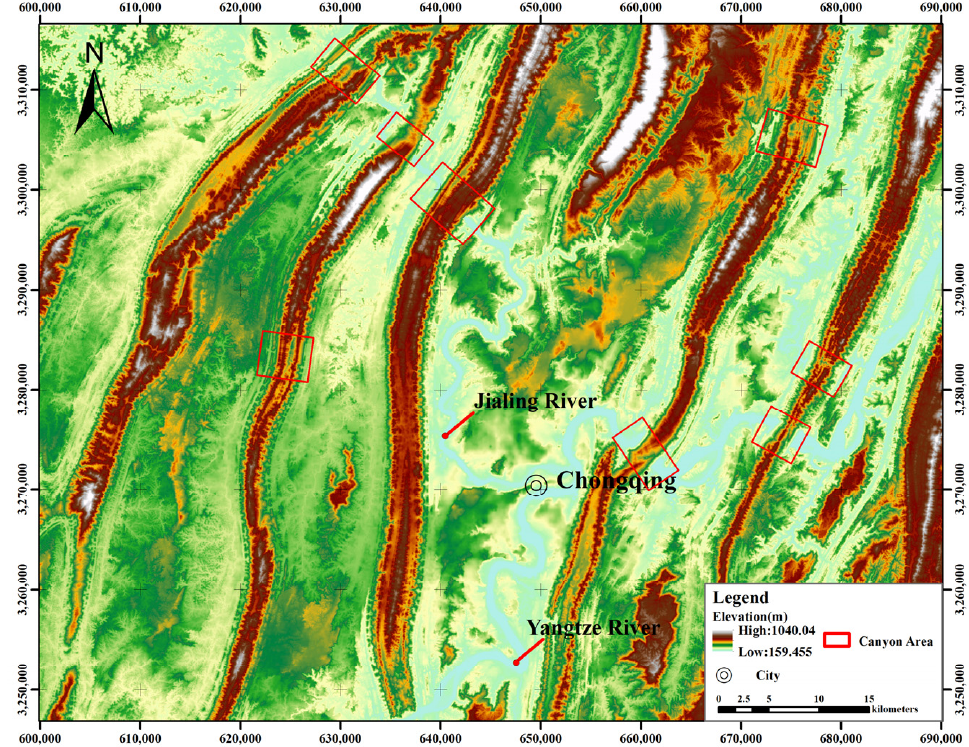
Figure 16. The paleotopographic DEM of the study region. Table 1. The values of the spatial attributes-surface area and volume-of each transverse canyon.